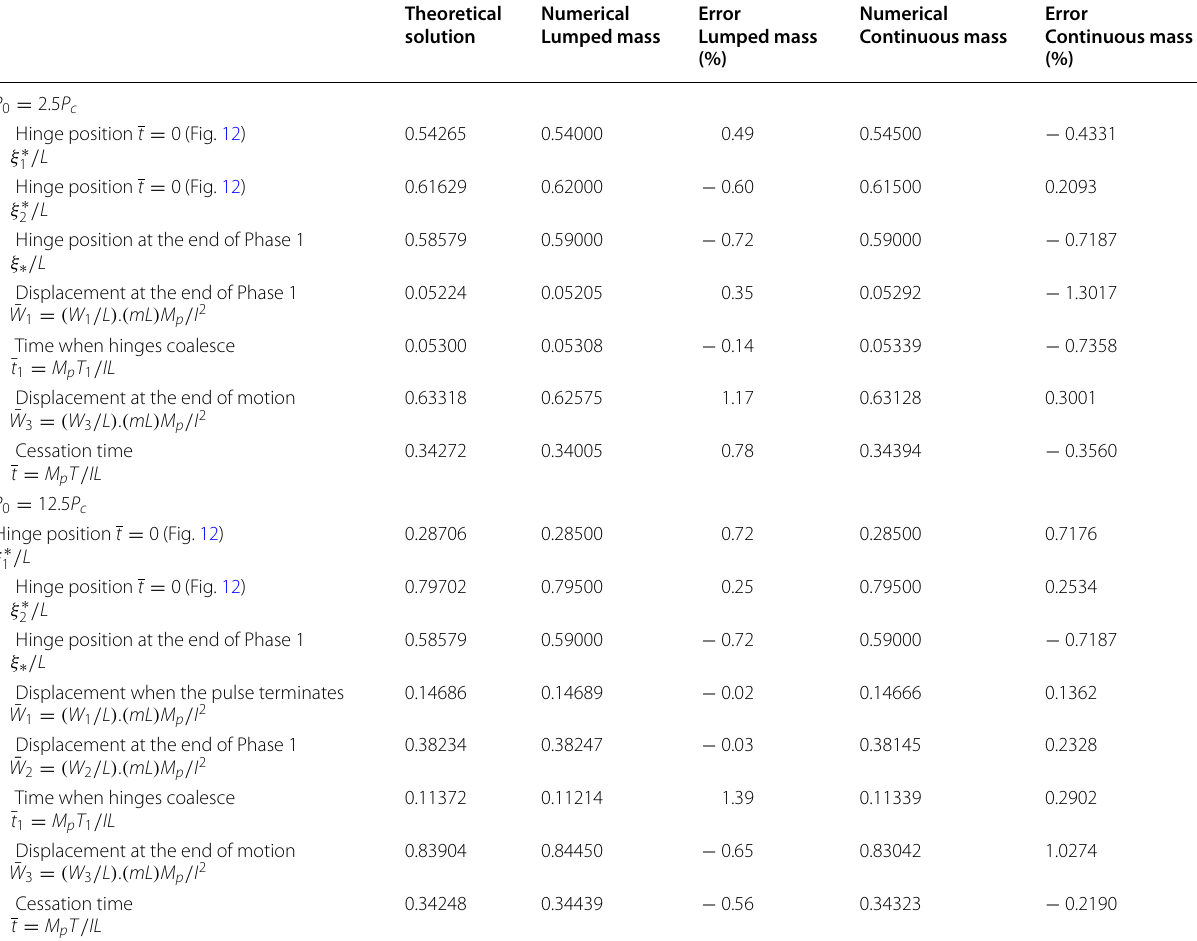
Table 2 Comparison between theoretical solution and numerical LCP